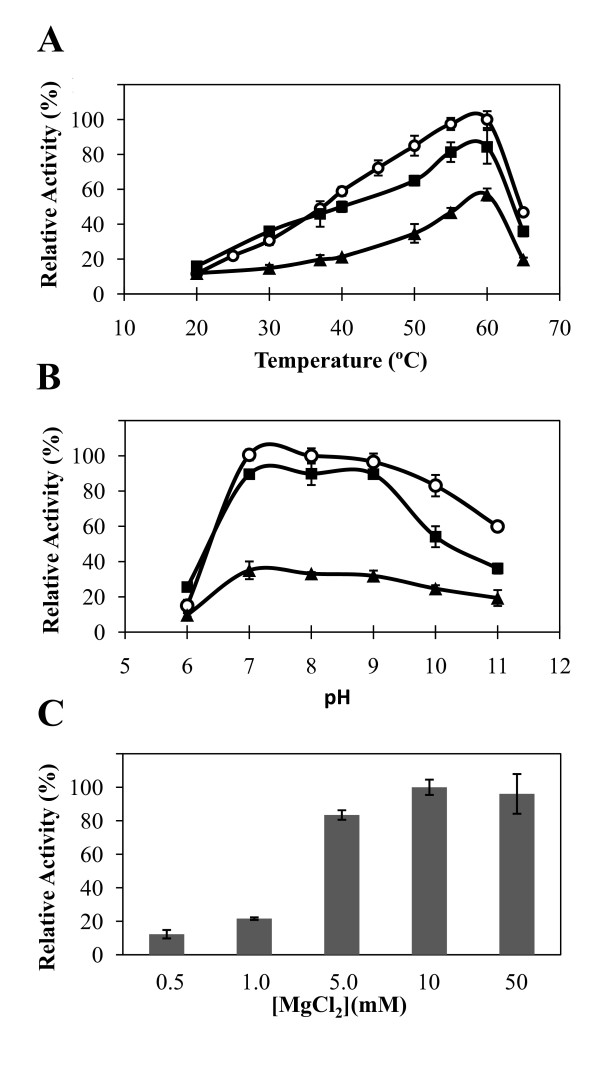
Effects of temperature, pH and Mg2+ concentration on Mak activity. Temperature profile (A) and pH dependence (B) using ATP (white circle), GTP (black circle) and UTP (black triangle) as phosphate donors. (C) Effect of Mg2+ concentration.